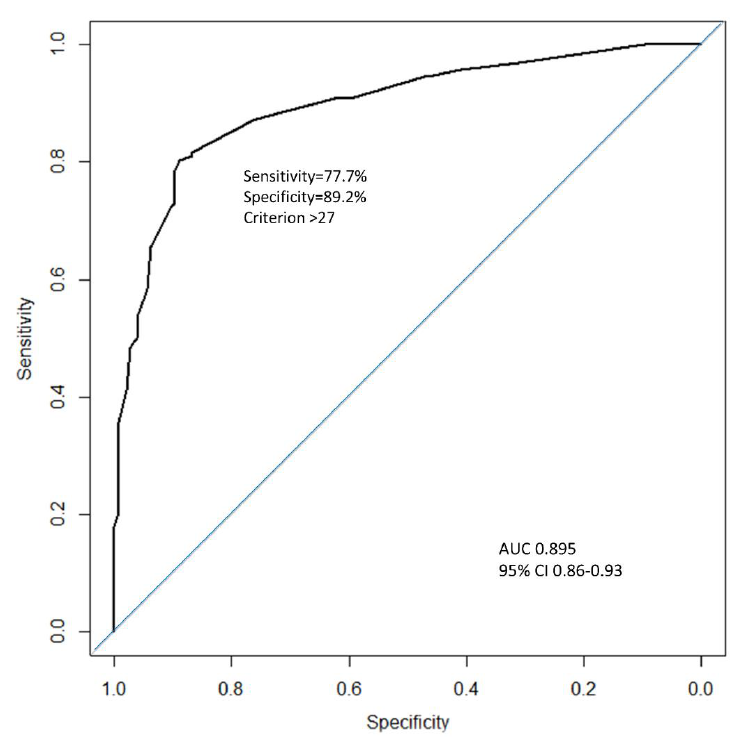
Figure 3. ROC curve of the DIABCOVID hospitalization predicting score (black curve) and a random classifier (blue curve). classifier (blue